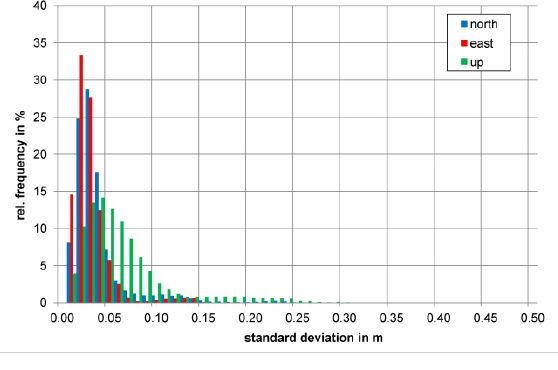
Figure 10. Histogram of standard deviation of north, east and up component from translational transformation of relative coordinates of GNSS antennas to the PPP-derived ab- solute coordinates.